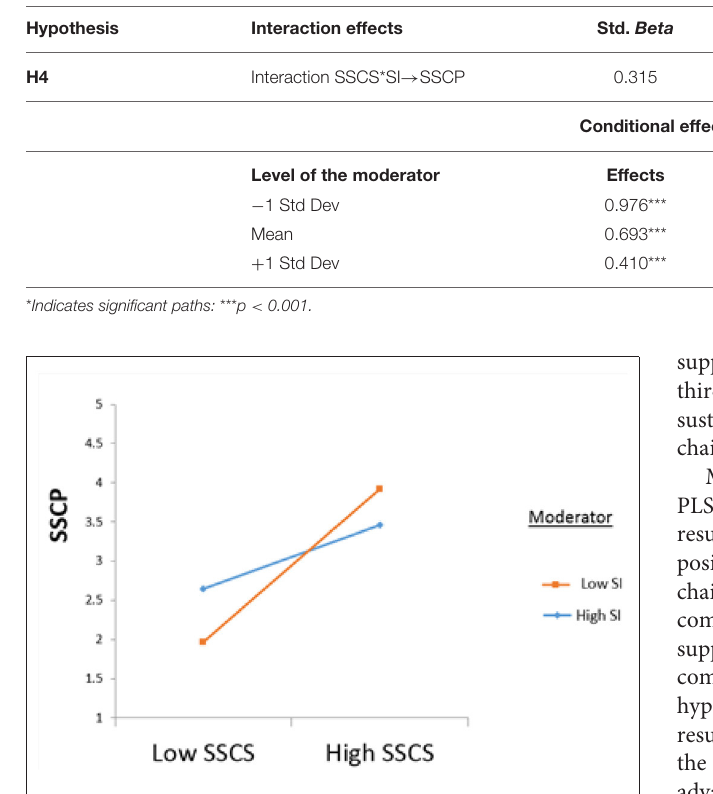
( β = 0.976, p < 0.001). Figure 3 shows the interaction effect of SSCS ∗